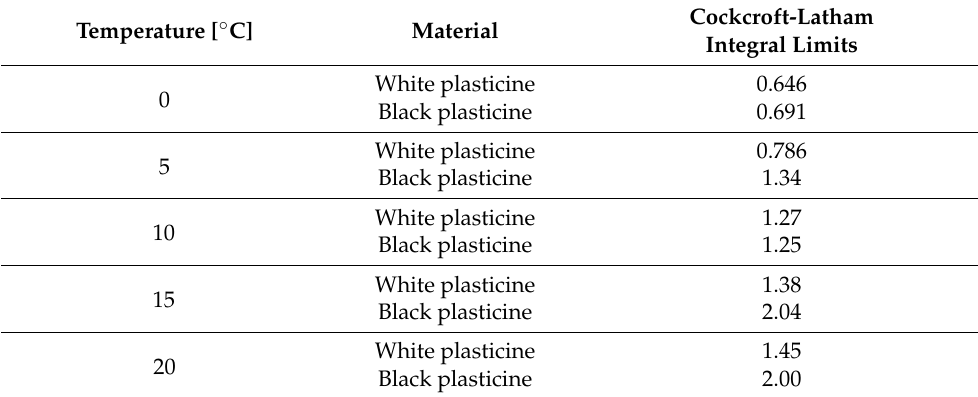
Table 2. Cockroft–Latham integral limits for PRIMO plasticine [56,57].